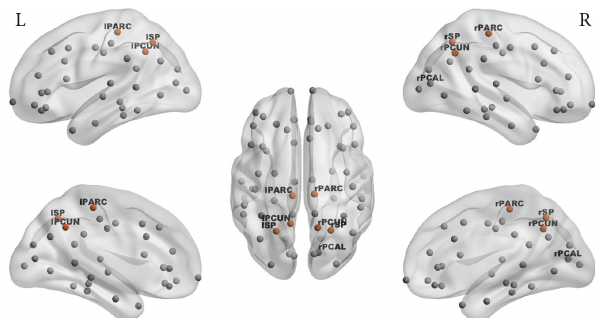
Figure 1: Spatial representation of the nodes that have been used in the present model. In red, the nodes whose connectivity was temporarily increased are indicated. PARC (paracentral lobe), PCUN (precuneus), and SP (superior parietal cortex). L: left and R: